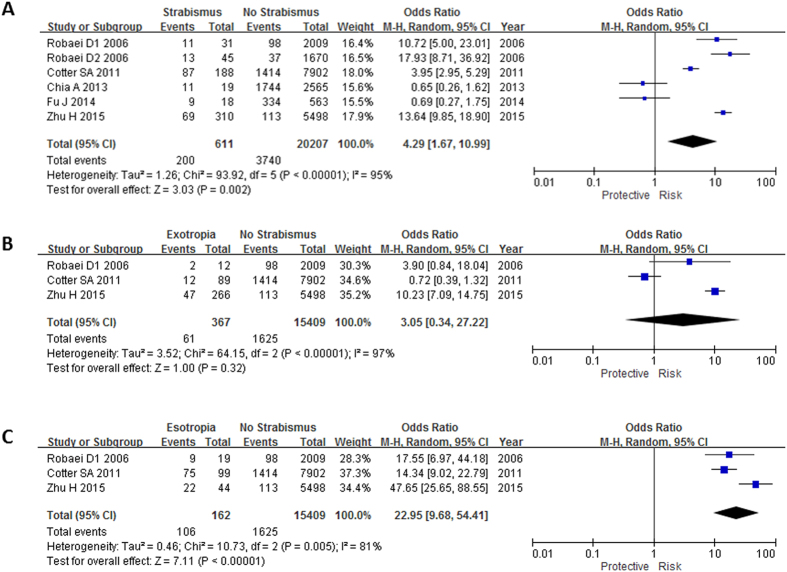
Meta-analysis of the association of hyperopia with different types of strabismus.The bars with squares in the middle represent 95% confidence intervals (95% CIs) and odds ratios (ORs). The central vertical solid line indicates the ORs for the null hypothesis. Diamond indicates summary OR with its corresponding 95% CI. (A) Association between hyperopia and strabismus. (B) Association between hyperopia and exotropia. (C) Association between hyperopia and esotropia.